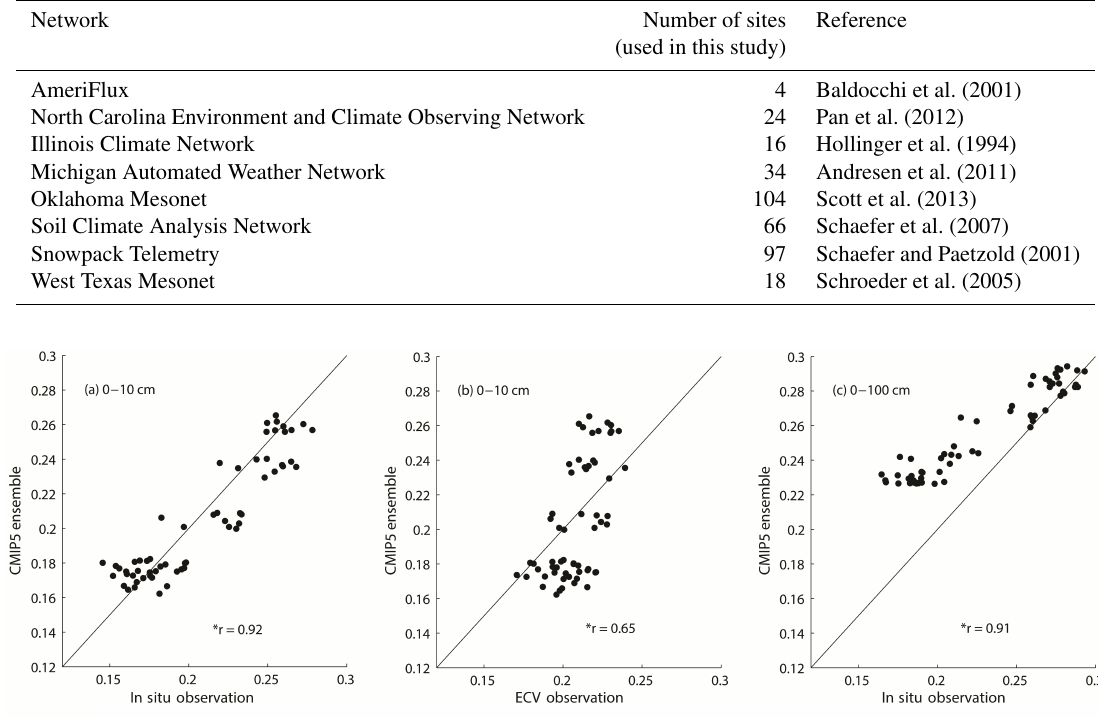
Table 2. List of observational networks in this study.